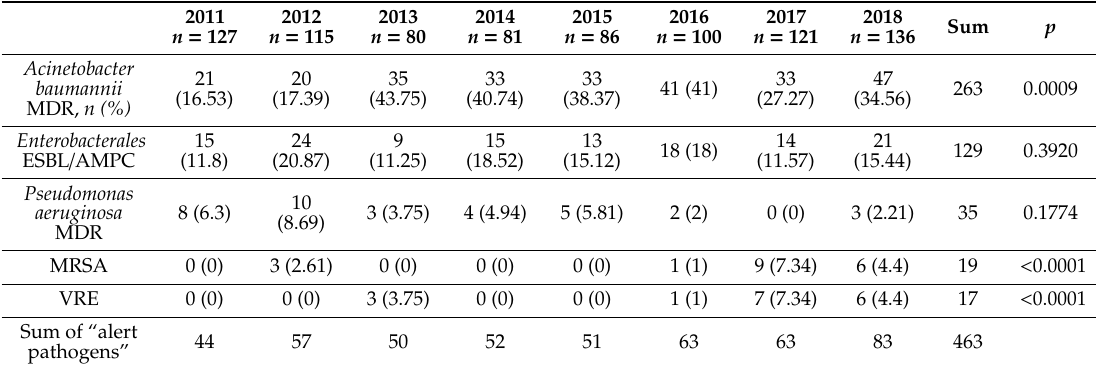
Table 2. Alert pathogens isolated from hospital-acquired infections in the years 2011—2018. The data were presented as numerical values and percentage of the overall number of isolates in individual